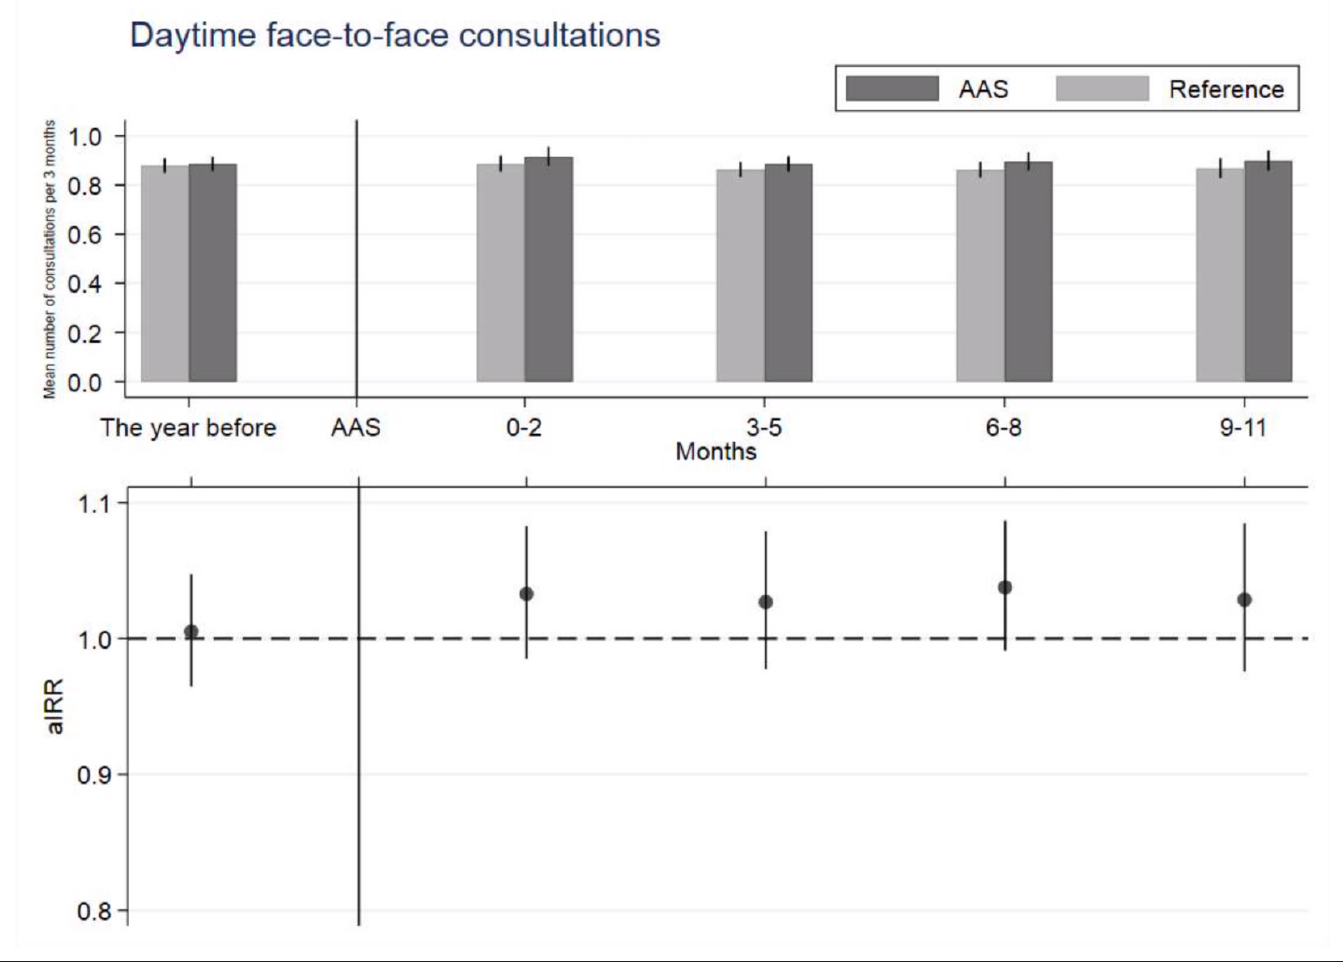
Figure 1 Daytime face- to- face consultations in general practice 1 year before and 1 year after the index date. The vertical line marks the index date. Upper part: mean number of consultations per patient per 3 months with 95% confidence intervals (CIs) for patients listed with advanced access scheduling (AAS) practices and reference practices. Lower part: adjusted incident rate ratios (aIRRs) with 95% CIs adjusted for sex, age, vital status, ethnic group, cohabitation status, family income, highest- achieved education level, Charlson Comorbidity Index, calendar time, and month; all measured at the index